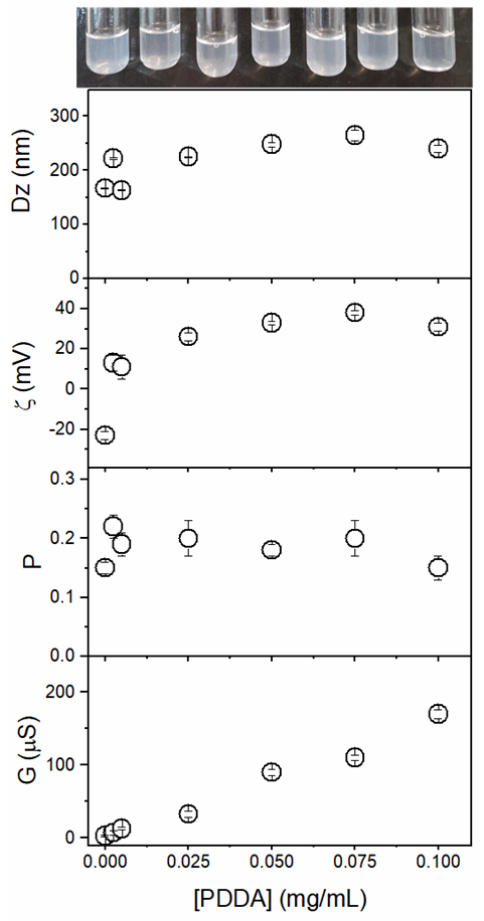
Figure 3. Effect of poly (diallyldimethyl ammonium chloride) (PDDA) concentration on the macroscopic aspect and physical properties of gramicidin (Gr)/PDDA dispersions at 0.05 mM Gr. Physical properties were the mean z-average diameter (Dz), the zeta potential (ζ), the polydispersity (P), and the conductance (G). All measurements represent a mean value ± the mean standard deviation.